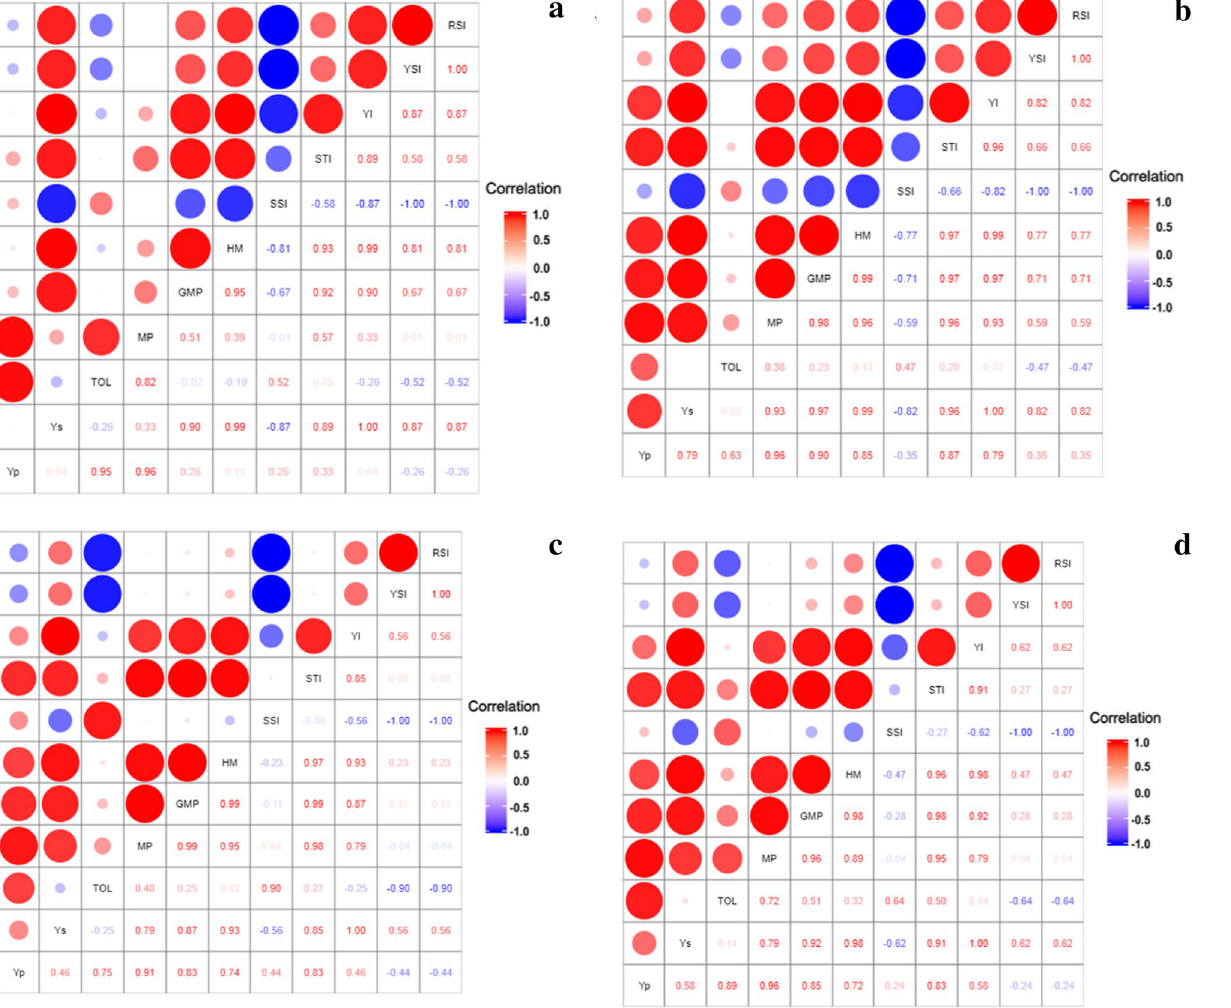
Figure 2. Correlation coefficients and diagram between grain yield under non-stress (YP), and drought stress condition (YS) along with nine indices values for the 152 rice RILs, parental (IR28 and SH: Shahpasand) and check varieties (N; Neda, S; Sadri, D; Dorfak) in 2017 ( a ), 2018 ( b ), 2019 ( c ) and average of all 3 years from 2017 to 2019 ( d